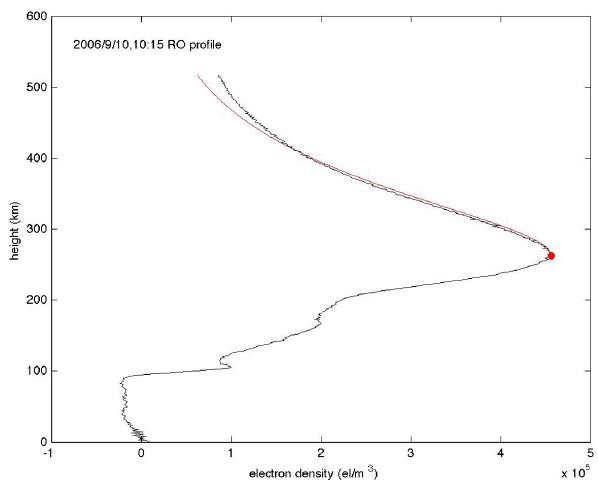
Fig. 1. Example of H T value by fitting α Chapman function (red line) between the F2-layer peak electron density point (red cir- cle) and the RO measurement (solid line) around 10:15UT on 10 September 2006 using an α Chapman